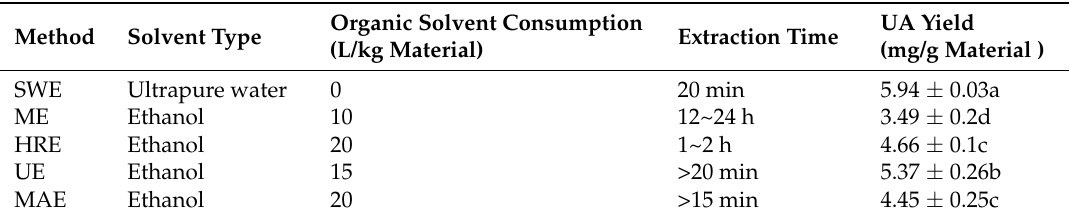
Table 3. Comparison of extraction methods for their solvent type, solvent consumption, time-consumption and extraction efficiency.